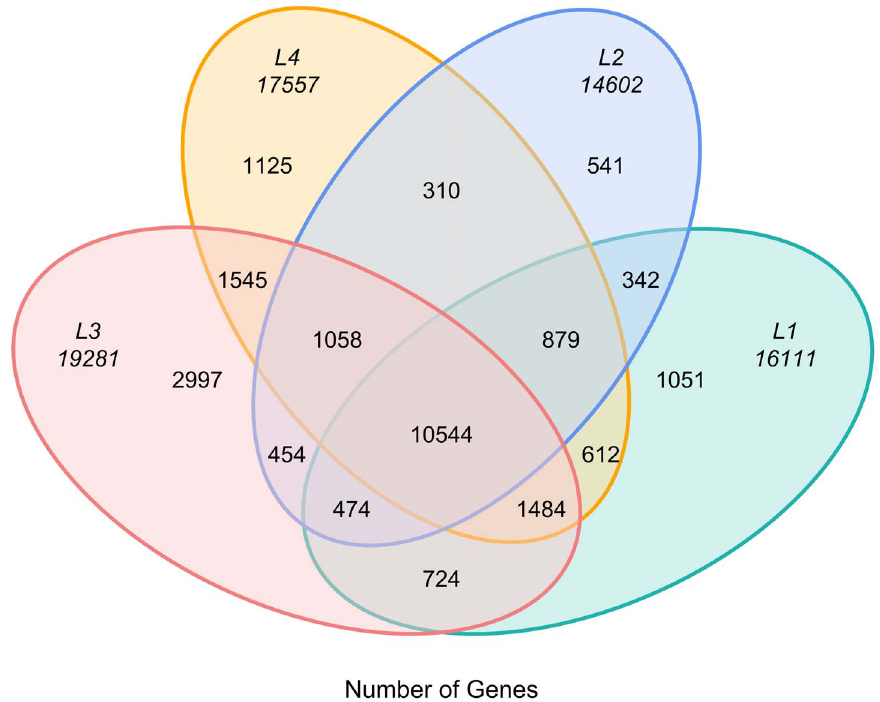
Figure 2. Analysis of tag mapped genes among four libraries.